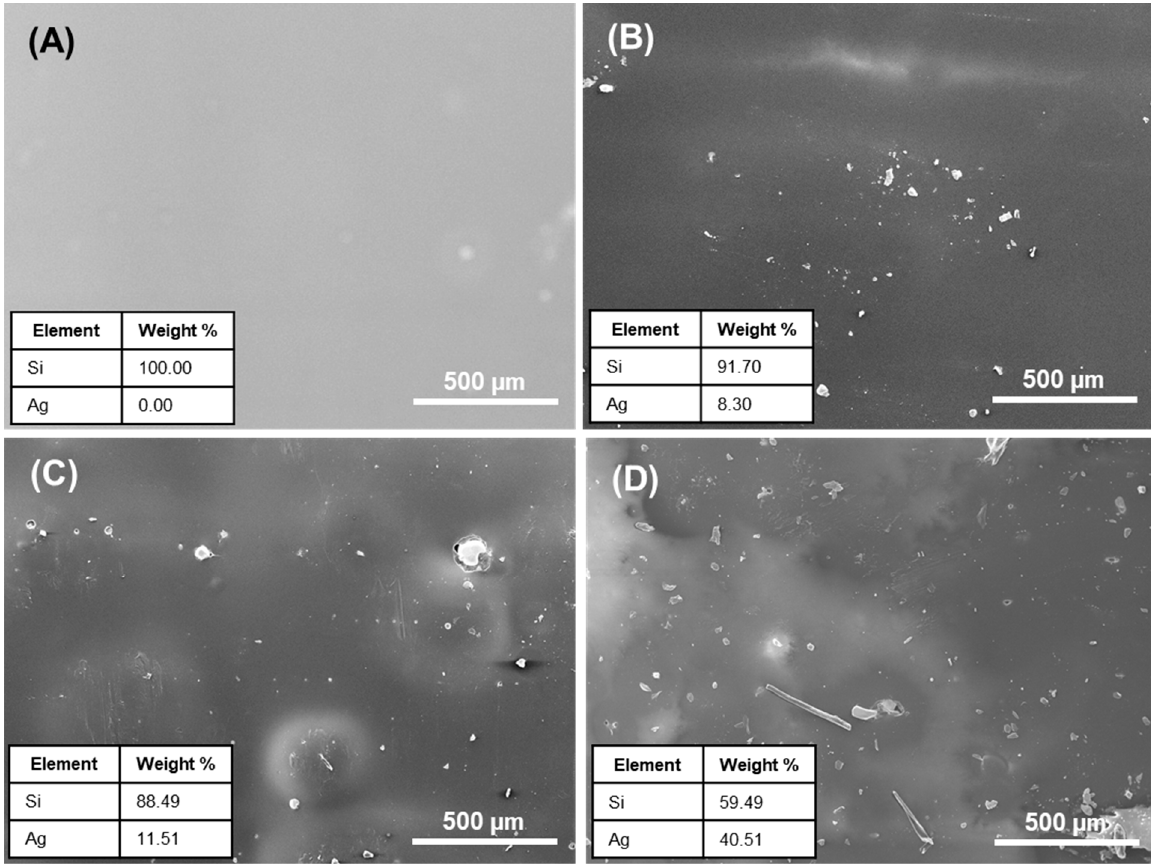
Figure 5. Morphological images and elemental analysis of ( A ) pristine Si thin film and ( B ) 30% Ag–Si, ( C ) 40% Ag–Si, and ( D ) 50% Ag–Si thin films.